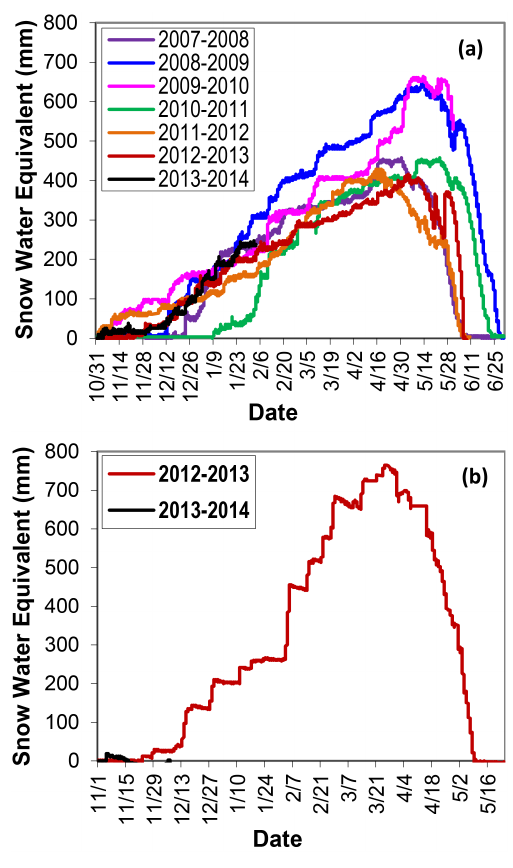
Figure 3. Snow water equivalent from snow pillows in the western Himalayas. (a) Deosai station – 4149ma.s.l.; (b) Shogran station –